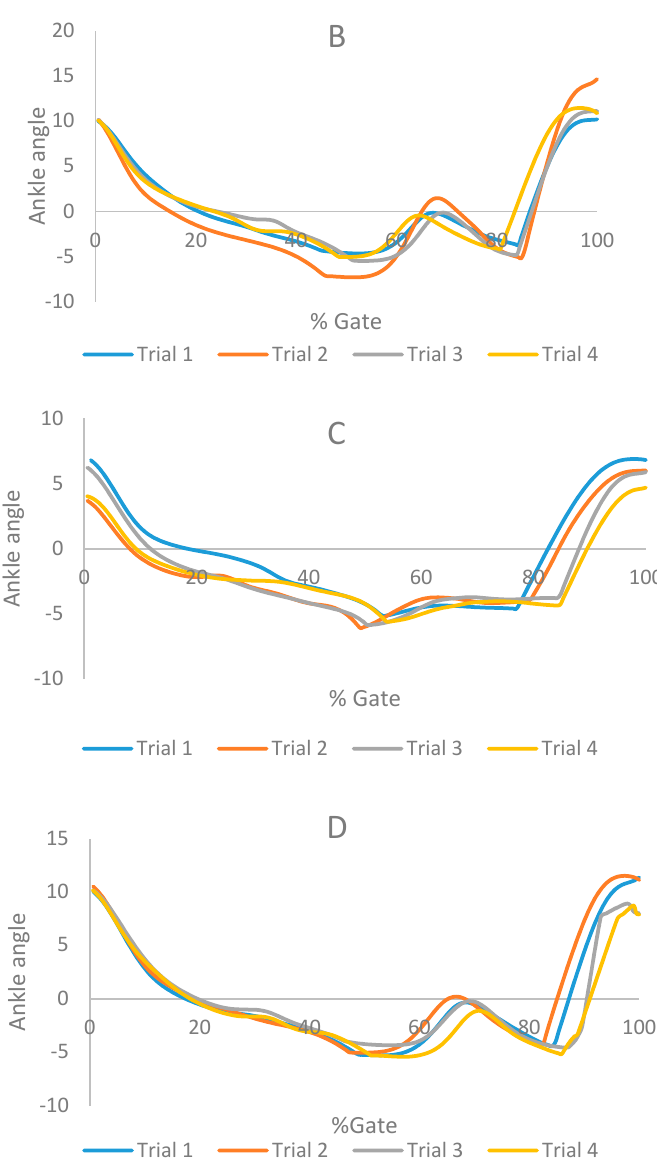
Figure 11. Ankle angle for each trial for different conditions including ( A ) subject with bare foot; ( B ) subject wearing conventional HAFO with no spring ( C ) subject wearing conventional Stainless Steel-based HAFO; and ( D ) subject wearing NiTi spring based HAFO. (Case І ).